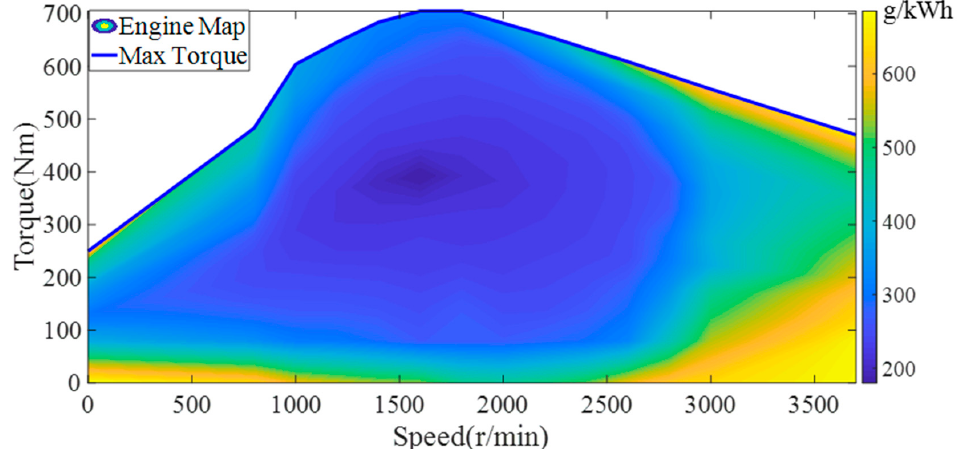
Figure 2. The fuel consumption map of the engine.